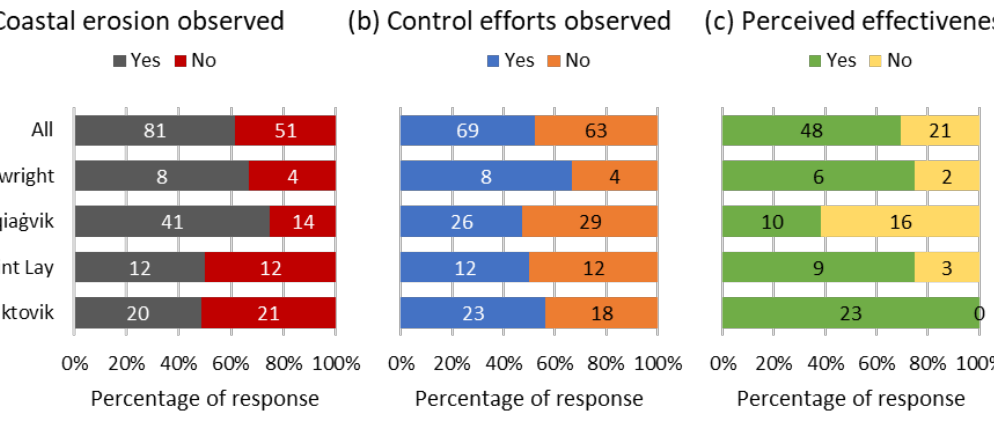
Figure 10. Observations of ( a ) coastal erosion, ( b ) its control efforts and ( c ) their perceived effective- ness.